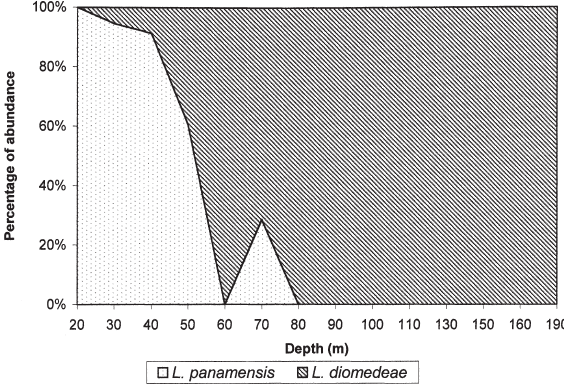
IG . 7. – Lolliguncula diomedeae and Lolliguncula panamensis . Abundance distribution by